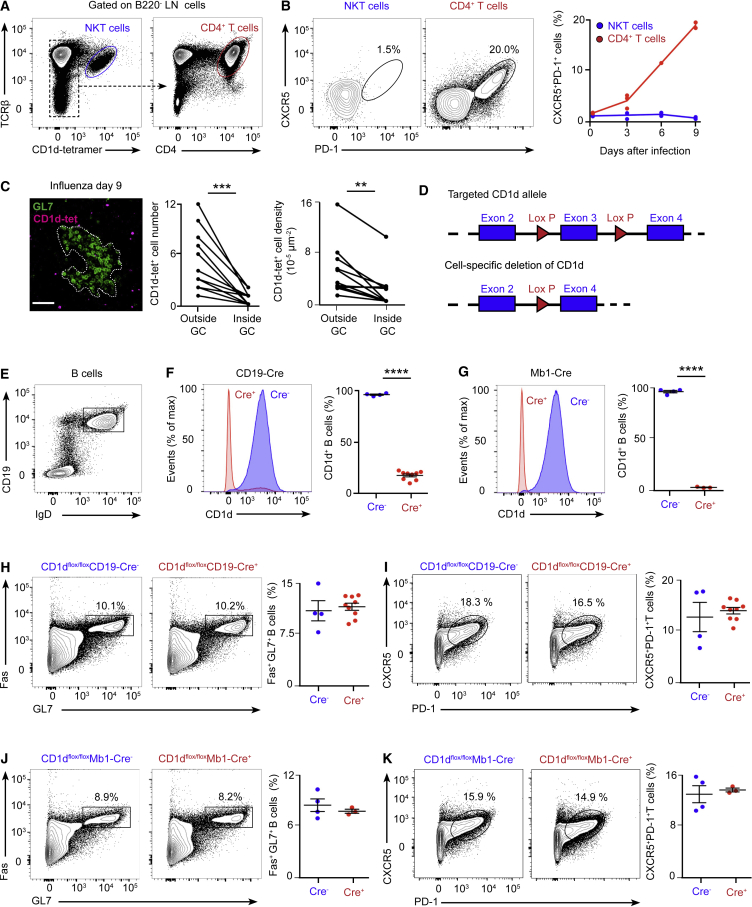
NKT Cells Deliver Non-cognate Help to B Cells during Viral Infection(A and B) Flow cytometry analysis of wild-type mice infected with influenza virus.(A) Gating strategy for NKT and CD4+ T cells. B220+ cells were excluded from the analysis.(B) Analysis of the percentage of NKT (blue) and CD4+ T (red) cells that acquire CXCR5 and PD-1 markers after infection.(C) Confocal microscopy analysis of lymph nodes on day 9 of influenza infection incubated with CD1d tetramer (magenta) and GL7 (green). Charts show the number and density of NKT cells inside and outside of germinal centers. Each dot represents a single germinal center. Scale bar, 60 μm.(D) Schematic showing the CD1d locus targeted for deletion with two loxP sites flanking exon 3 of CD1d.(E) Representative contour plot shows the gating strategy for B cells.(F and G) Flow cytometry analysis of CD1d expression in B cells from (F) CD1dflox/floxCD19-Cre or (G) CD1dflox/floxMb1-Cre mice: Cre− (blue) and Cre+ (red).(H–K) Flow cytometry analysis of germinal center and TfH cell formation in (H and I) CD1dflox/floxCD19-Cre or (J and K) CD1dflox/floxMb1-Cre mice on day 9 of influenza infection: Cre− (blue dots) and Cre+ (red dots).All data are representative of 3 independent experiments. Unless specified, each dot represents one mouse. Horizontal bars, mean; error bars, SEM; statistical analysis, two tailed Student’s t test, ∗∗p < 0.01, ∗∗∗p < 0.001, and ∗∗∗∗p < 0.0001.